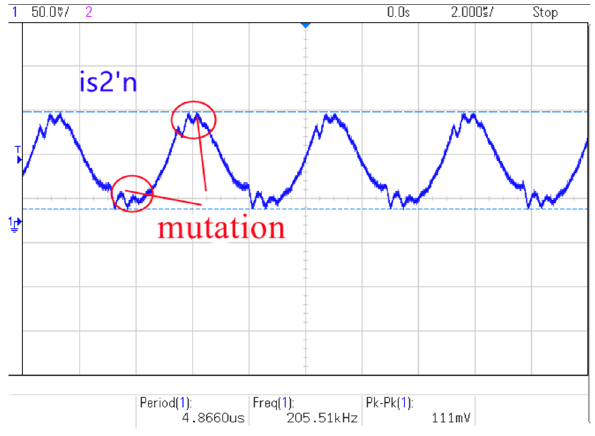
Figure 25. Traditional topological static 180° shifting input current waveform.